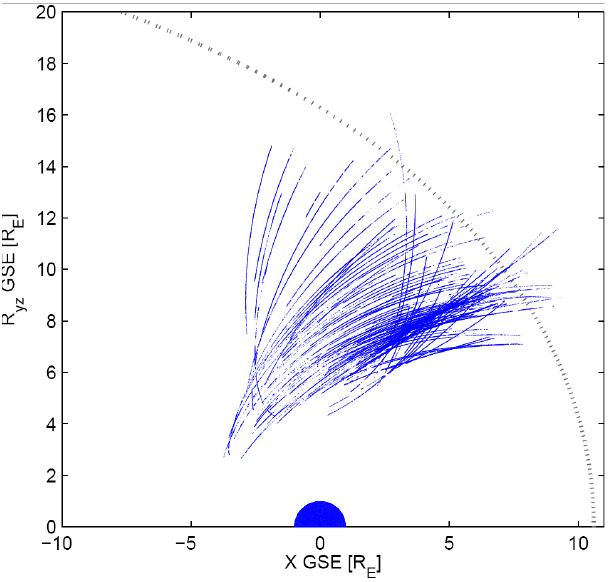
Fig. 1. The blue dots indicate where the data were taken in X and p Y 2 + Z 2 coordinates [ R E ]. Earth is indicated by the blue ball. R=